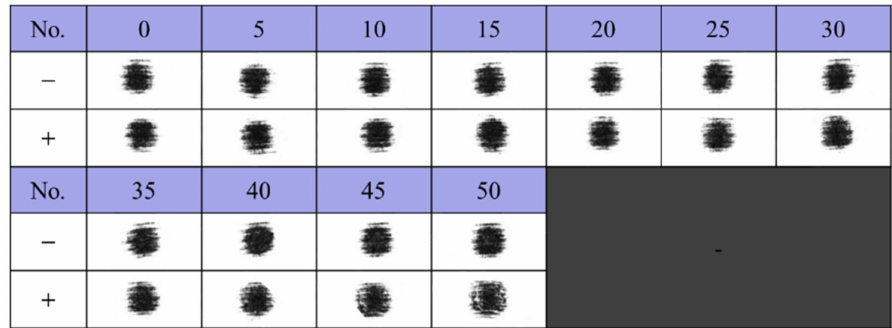
Figure 12. Carbon imprints of the as-received electrode at the electrode force of 600 kgf during continuous RSW.